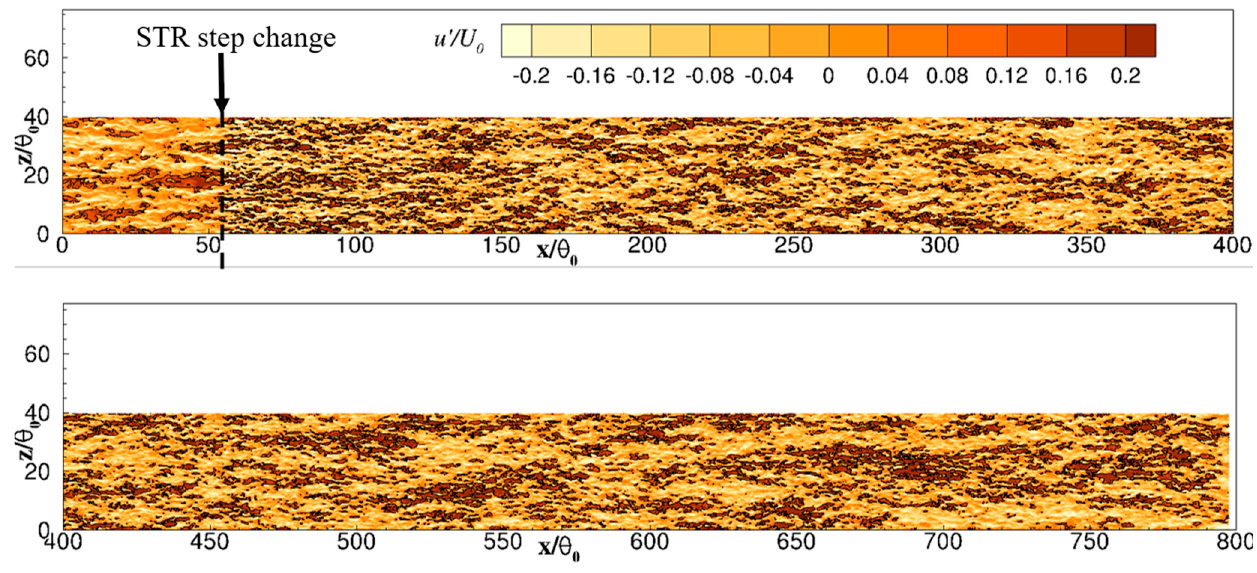
Figure 17. Instantaneous streamwise fluctuations 𝑢 (cid:4593) /𝑈 (cid:2998) in an 𝑥𝑧 − plane at 𝑦 = 1.2𝑘 . Top panel 0 ≤ 𝑥/𝜃 (cid:2868) ≤ 400 ; bottom panel: 400 ≤ 𝑥/𝜃 (cid:2868) ≤ 800 . Solid lines on top of the color contours indicate 𝑢 (cid:4593) /𝑈 (cid:2998) = 0.1.